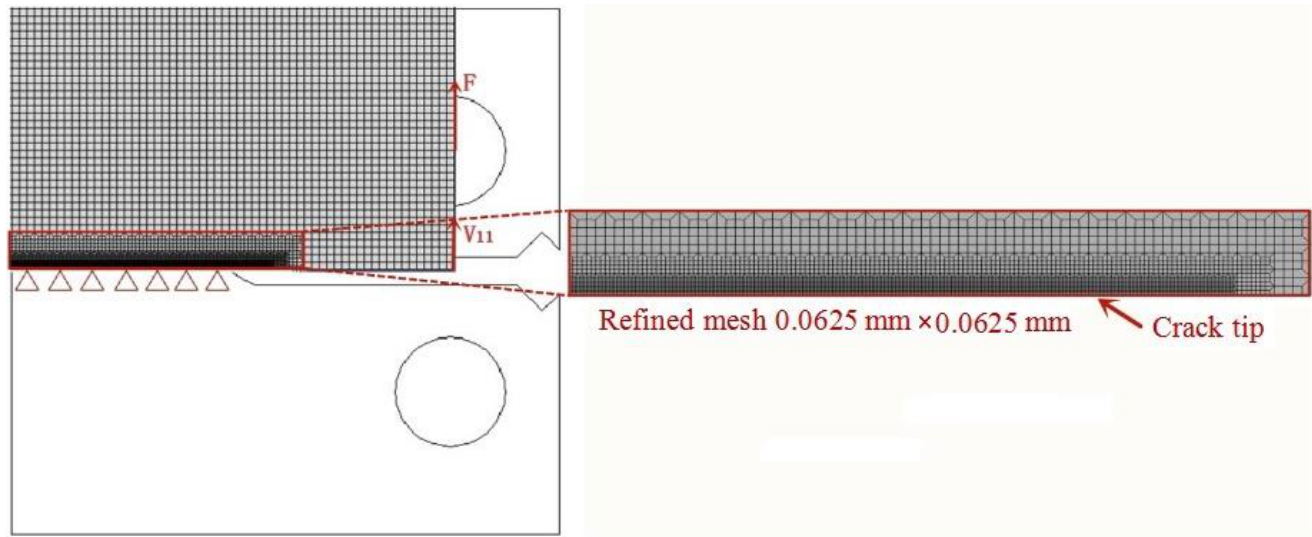
Figure 5. Finite element model for the (CT) specimen.